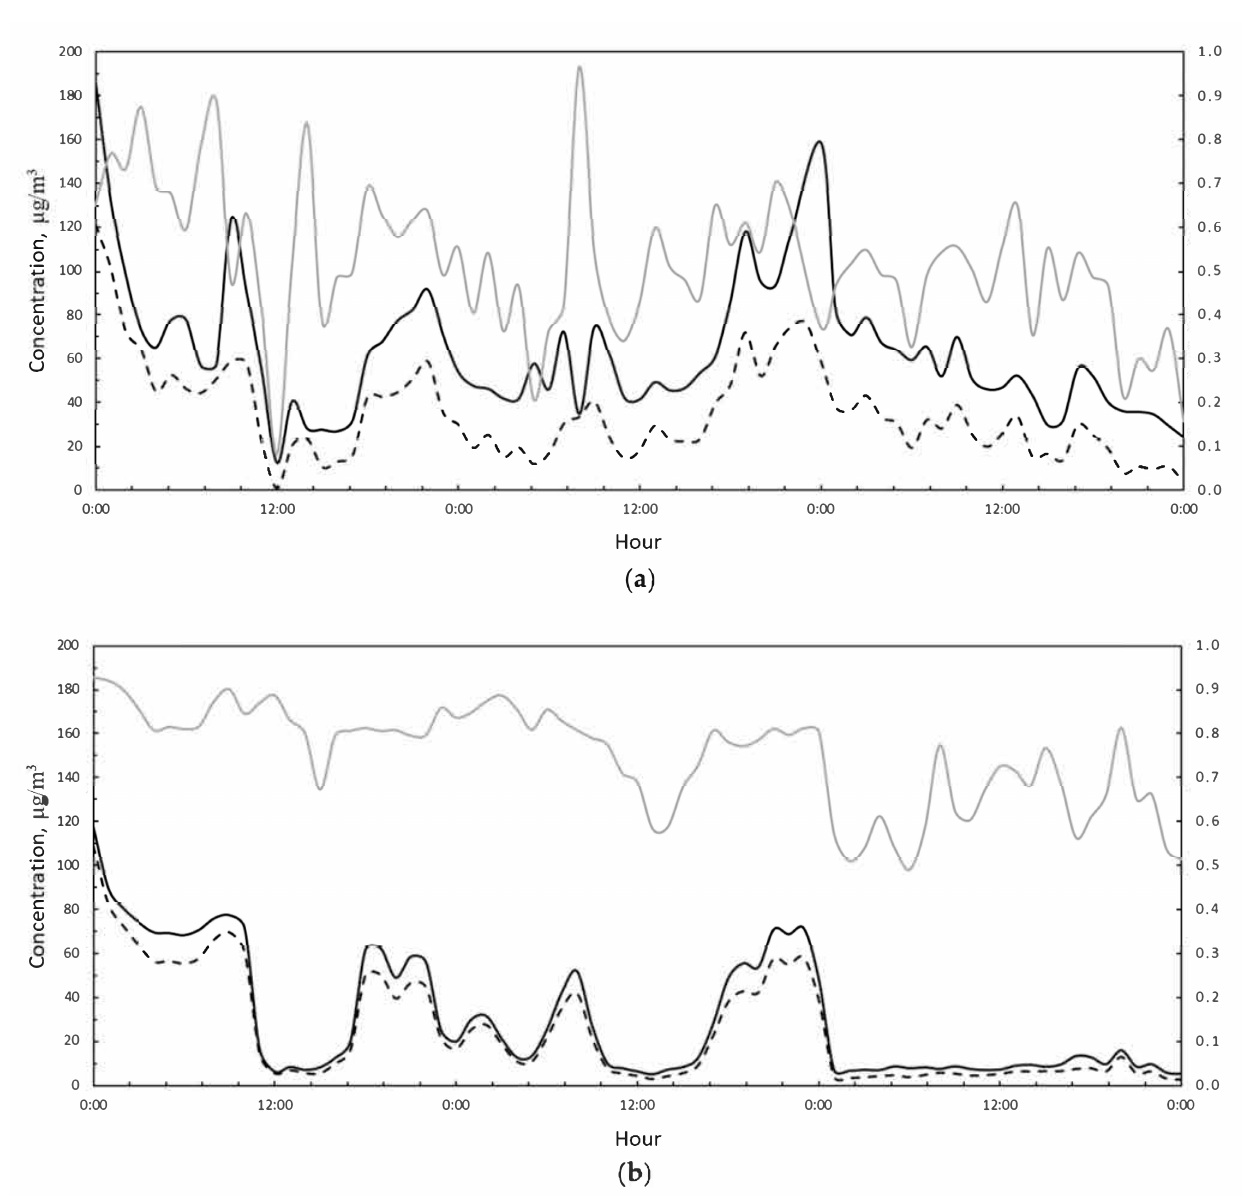
Figure 7. ( a ) PM10 (black solid line), PM2.5 (black dashed line), and PM2.5/PM10 hourly concentrations (grey solid line) measured during the period 5–7 February 2021 at the VC station. ( b ) PM10 (black solid line), PM2.5 (black dashed line), and PM2.5/PM10 hourly concentrations (grey solid line) measured during the period 5–7 February 2021 at the MV